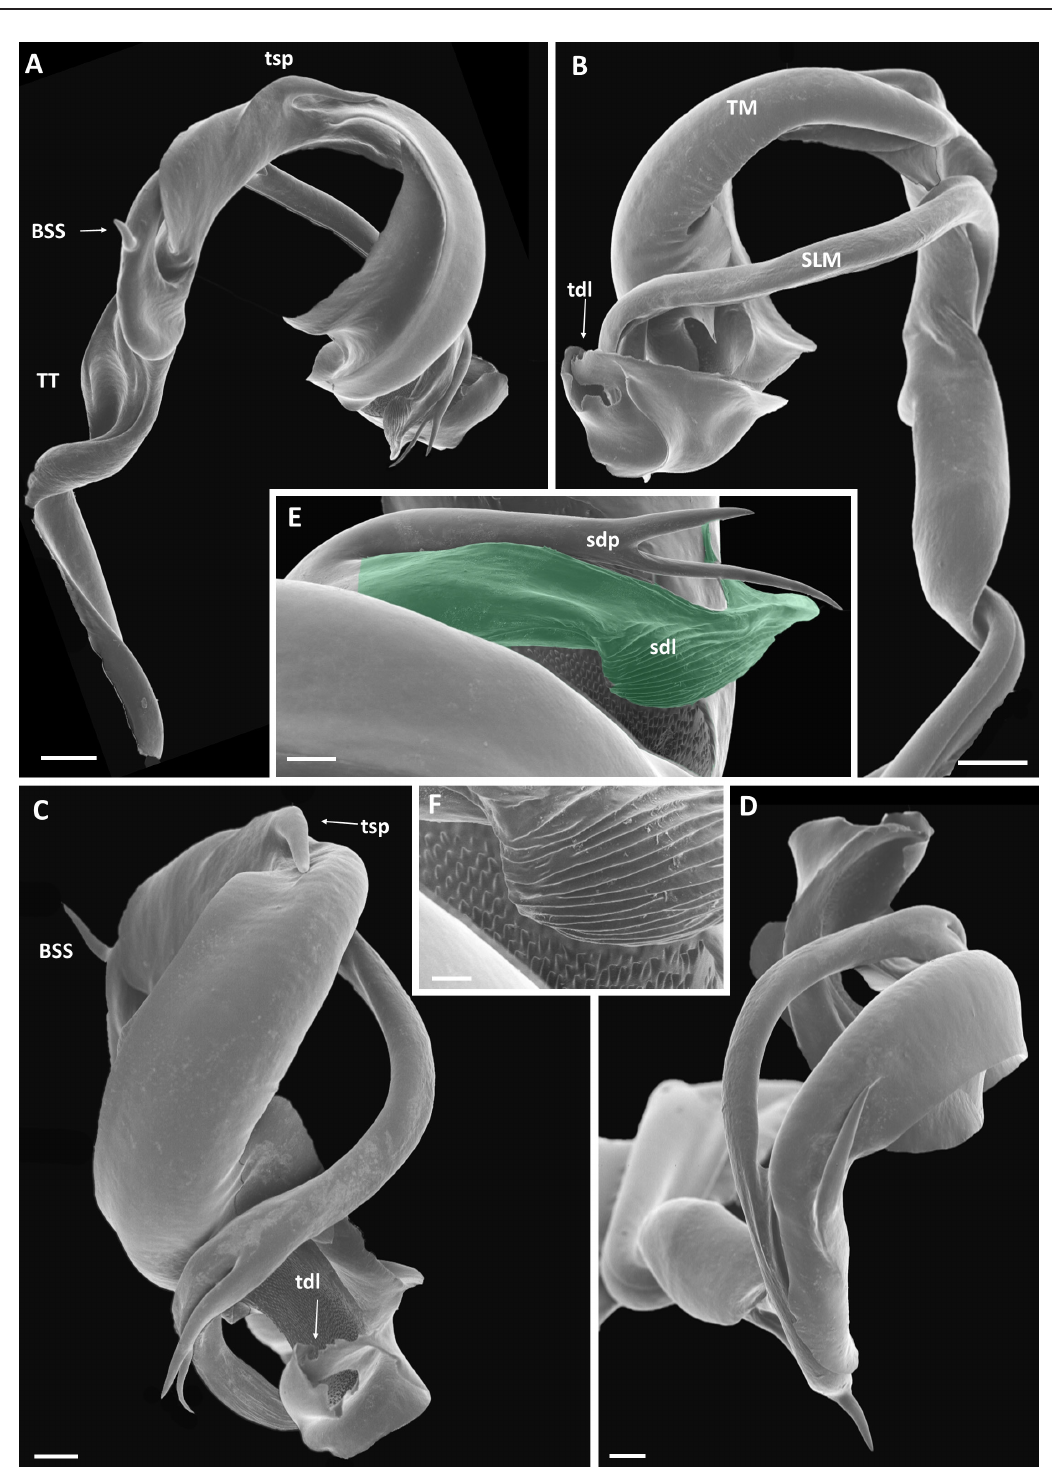
Fig. 74. Xystopyge proplicatus Frederiksen & Enghoff, 2012, specimen from Kasanga (NHMD 621774). A . (Dorso-)anterior view. B . (Ventro-)posterior view. C . Ventral view. D . Mesal view. E . Tip of solenomere, solenomeral distal lobe ( sdl ) highlighted in green. F . Close-up of fluted areas of solenomeral distal lobe and microspiculate inner surface of telomere. Abbreviations: BSS = basal solenomeral spine; sdl = soloenomeral distal lobe; sdp = solenomeral distal process; SLM = solenomere; TM = telomere; tsp = telomeral spinelike process. Scale bars: A–B = 0.2 mm; C–D = 0.1 mm; E = 0.005 mm; F = 0.02